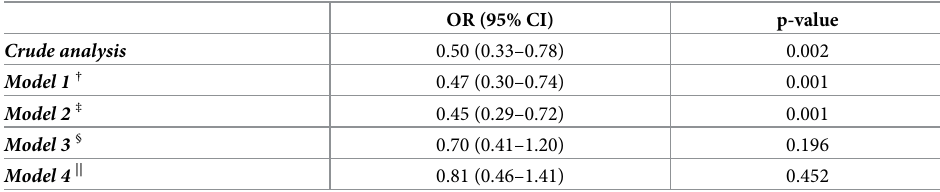
Table 2. Crude and adjusted odds ratios for hospital mortality between groups �